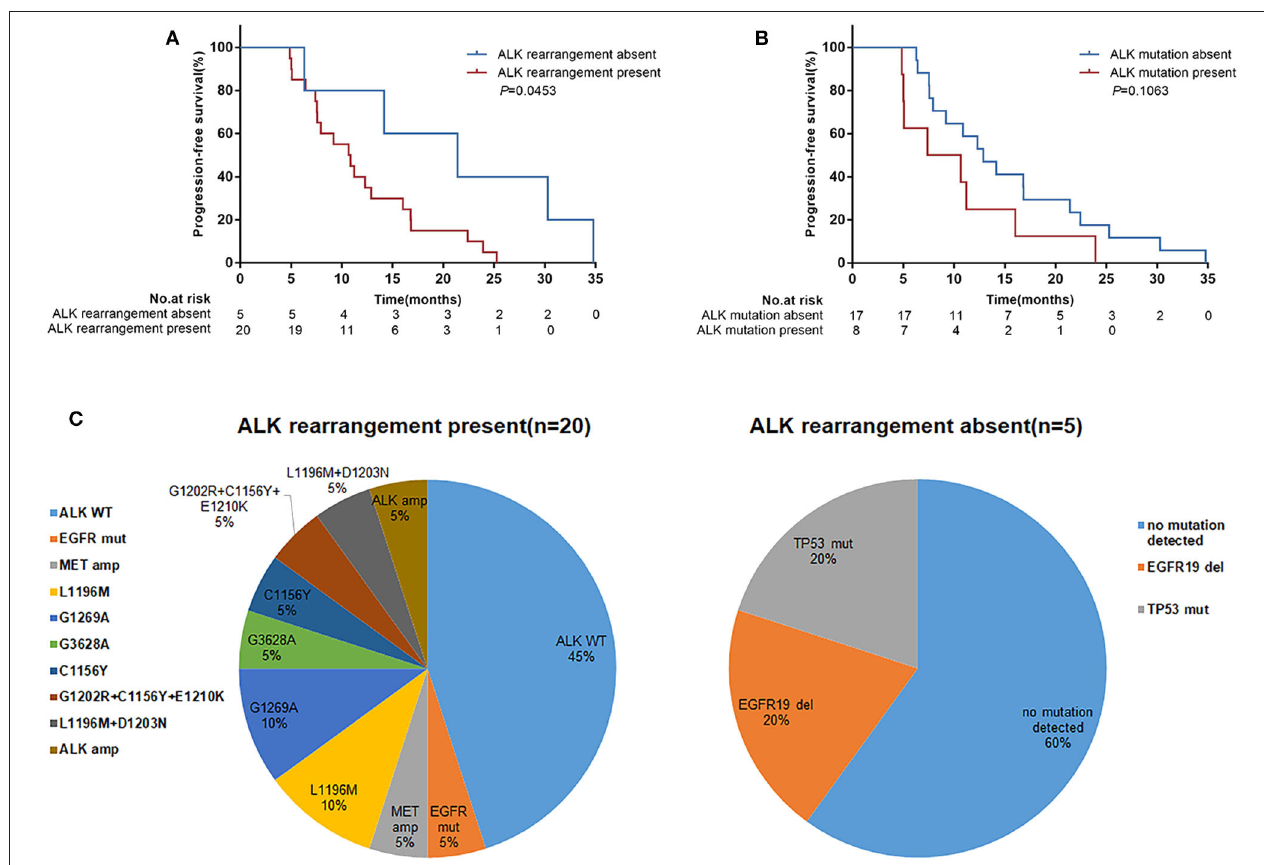
FIGURE 4 | Progression-free survival (PFS) according to ALK resistance mechanisms detected in repeat tumor biopsies following disease progression on crizotinib treatment. (A) Patients with ALK rearrangement absent ( n = 5) vs. ALK rearrangement present ( n = 20); (B) Patients with ALK mutations absent ( n = 17) vs. ALK mutations present ( n = 8). p -values were calculated using the log-rank test. (C) Distribution of ALK resistance mutations after disease progression on crizotinib treatment by ALK rearrangement present or absent. WT, wild-type; amp, amplification; mut, mutation; del,